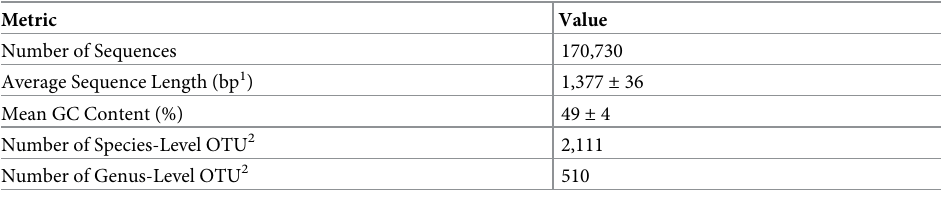
Table 1. Bovine URT database